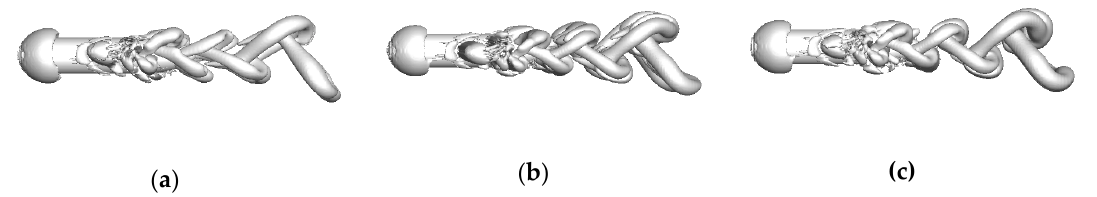
Figure 7. Side view of the vortex structures for three typical AR values ( a ) AR = 1.0; ( b ) AR = 1.0; and ( c ) AR = 5.0.